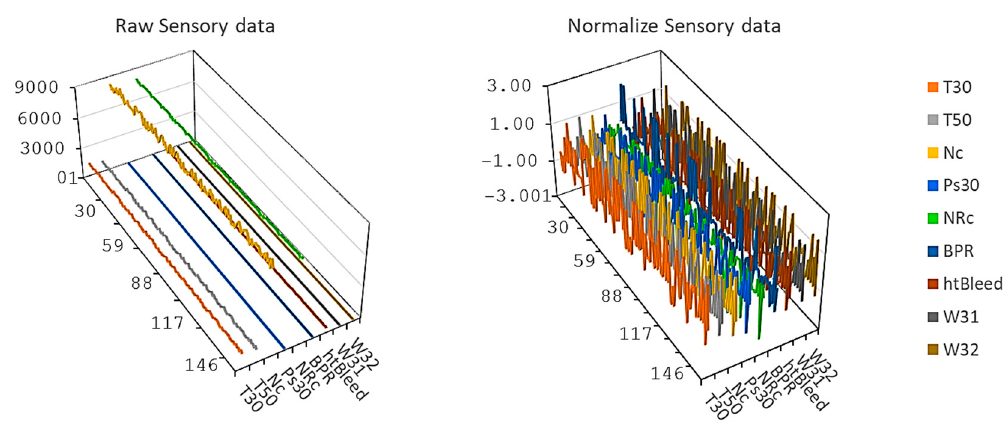
Figure 7. Example of before ( left ) and after ( right ) z-normalization.